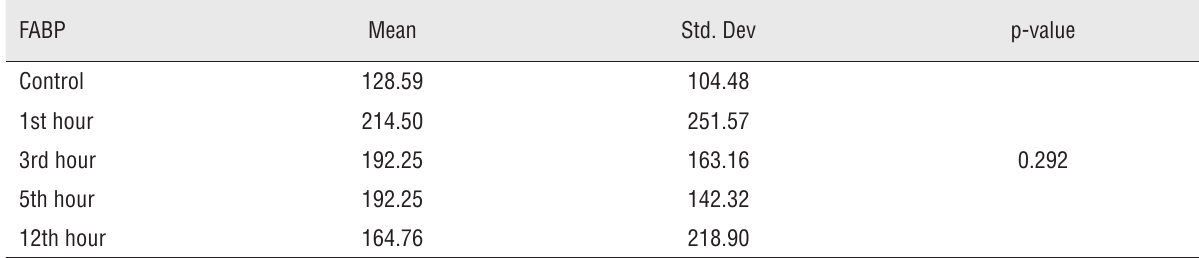
Table 2 - Time-linked variation in FABP (pg/mL) measured in urine. FABP